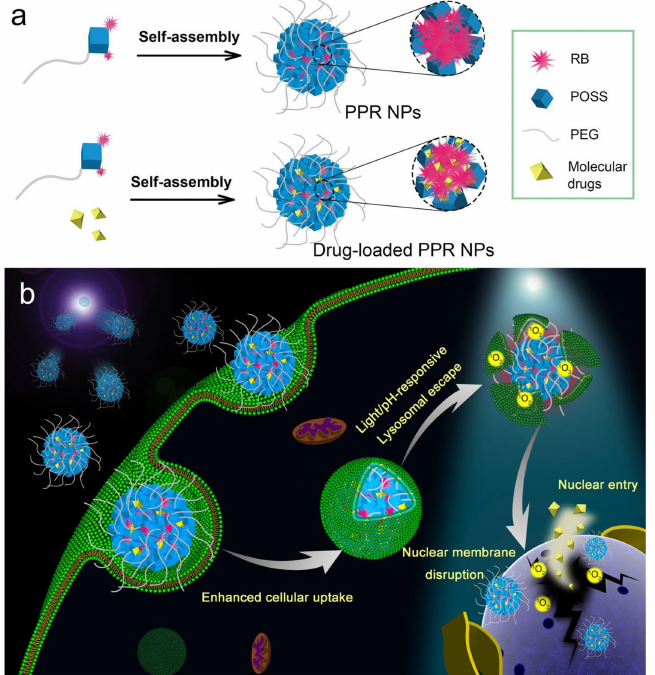
Figure 5. ( a ) The formation of PPR NPs and PPR/HCPT NPs and ( b ) the pH-responsive and light-triggerable nuclear delivery strategy using PPR/HCPT NPs as an example. Reprinted with permission from ref. [98]. Copyright 2018 American Chemical